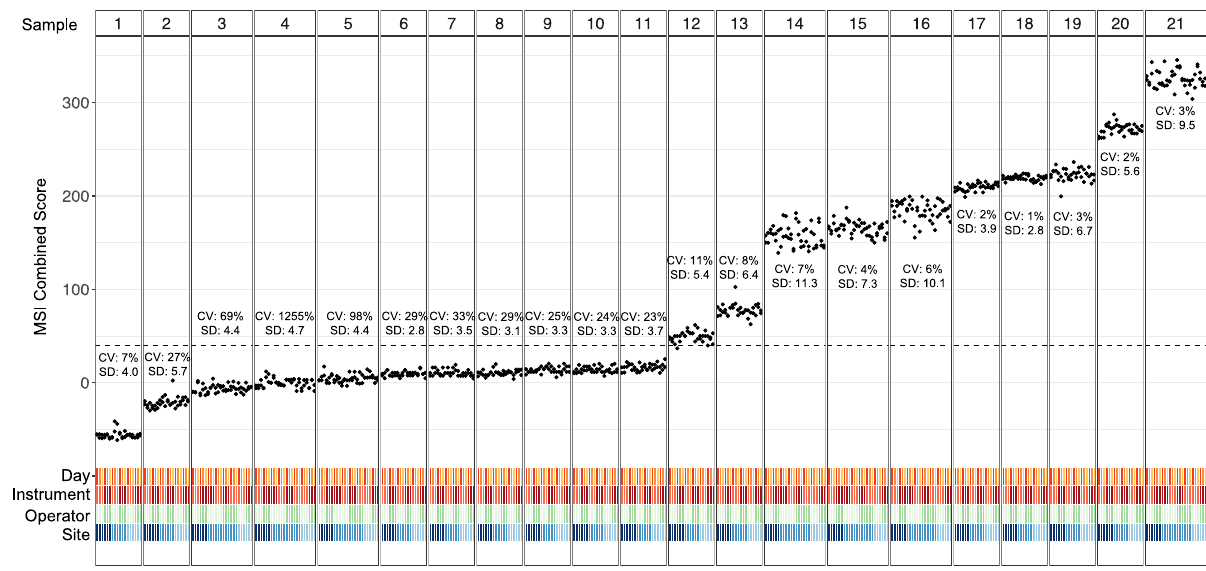
Fig. 6 Analytical precision and reproducibility of the elio tissue complete MSI detection algorithm. Precision and reproducibility of the microsatellite instability (MSI) status from elio tissue complete were evaluated across three independent clinical laboratories using 21 FFPE and cell-line samples. At each site, each sample was analyzed by two operators on two sequencing instruments across three non-consecutive days as indicated. The absolute value of the coef fi cient of variation (CV) and standard deviation (SD) for each sample are indicated. Samples with a combined score above the dotted line are considered microsatellite instability-high, demonstrating high performance of MSI across standard clinical laboratory variables. Source data are provided as a Source Data fi le.